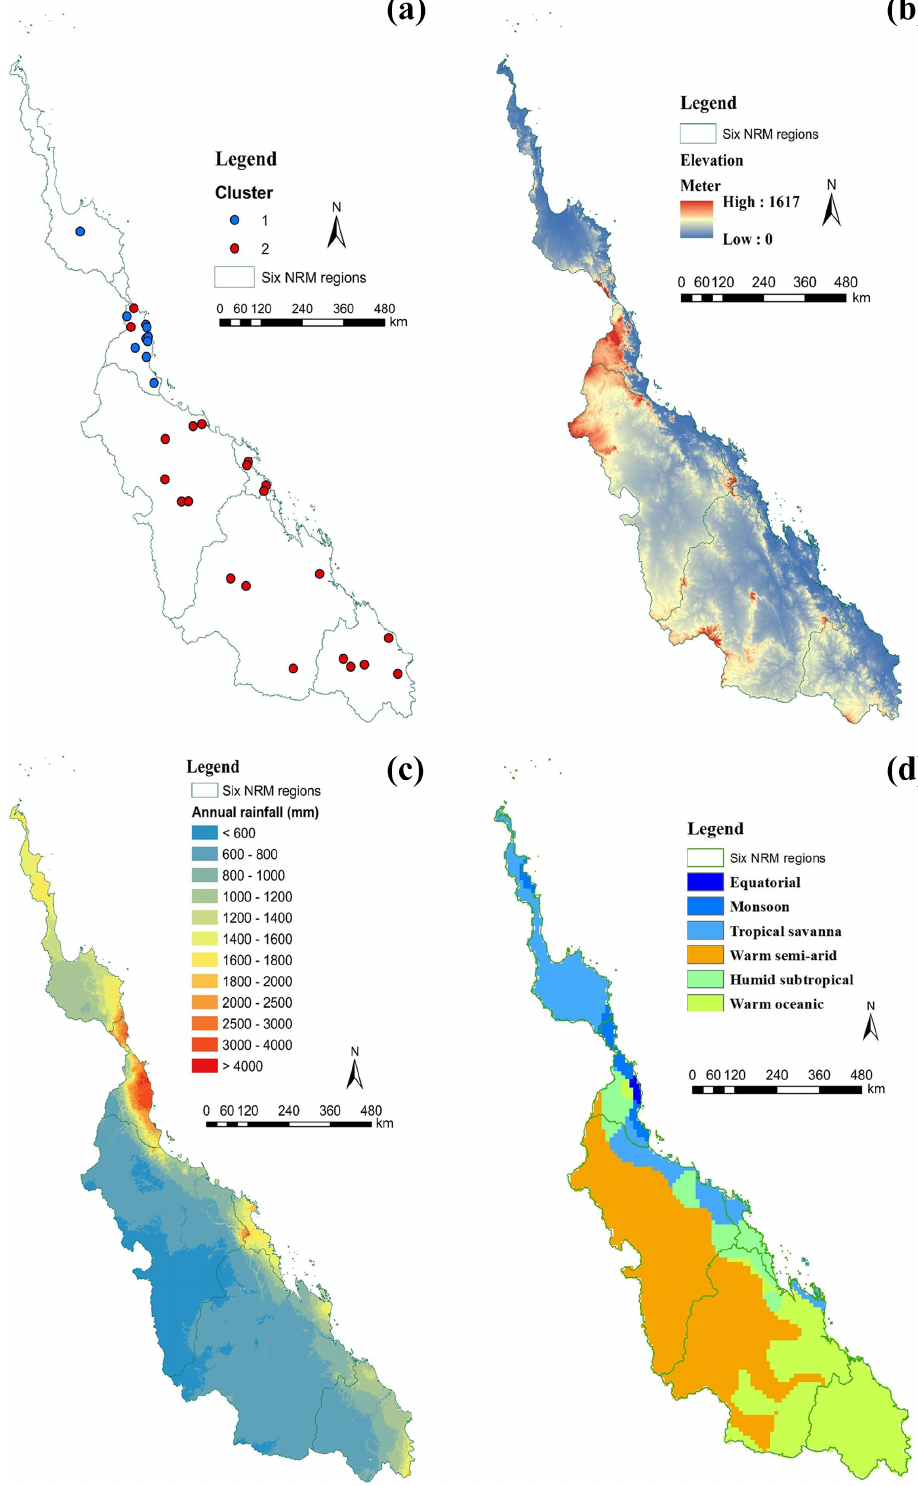
Figure 2. Spatial information of the GBR catchments northeastern Australia. (a) Site locations showing two groups based on the clustering analysis of spatial variability in time-averaged water quality (Liu et al., 2018). (b) Topographic elevation (250m resolution; Geoscience Australia, 2008). (c) Annual average rainfall (Atkinson et al., 2008, 2012). (d) Updated Köppen–Geiger climate zone classification (Peel et al.,